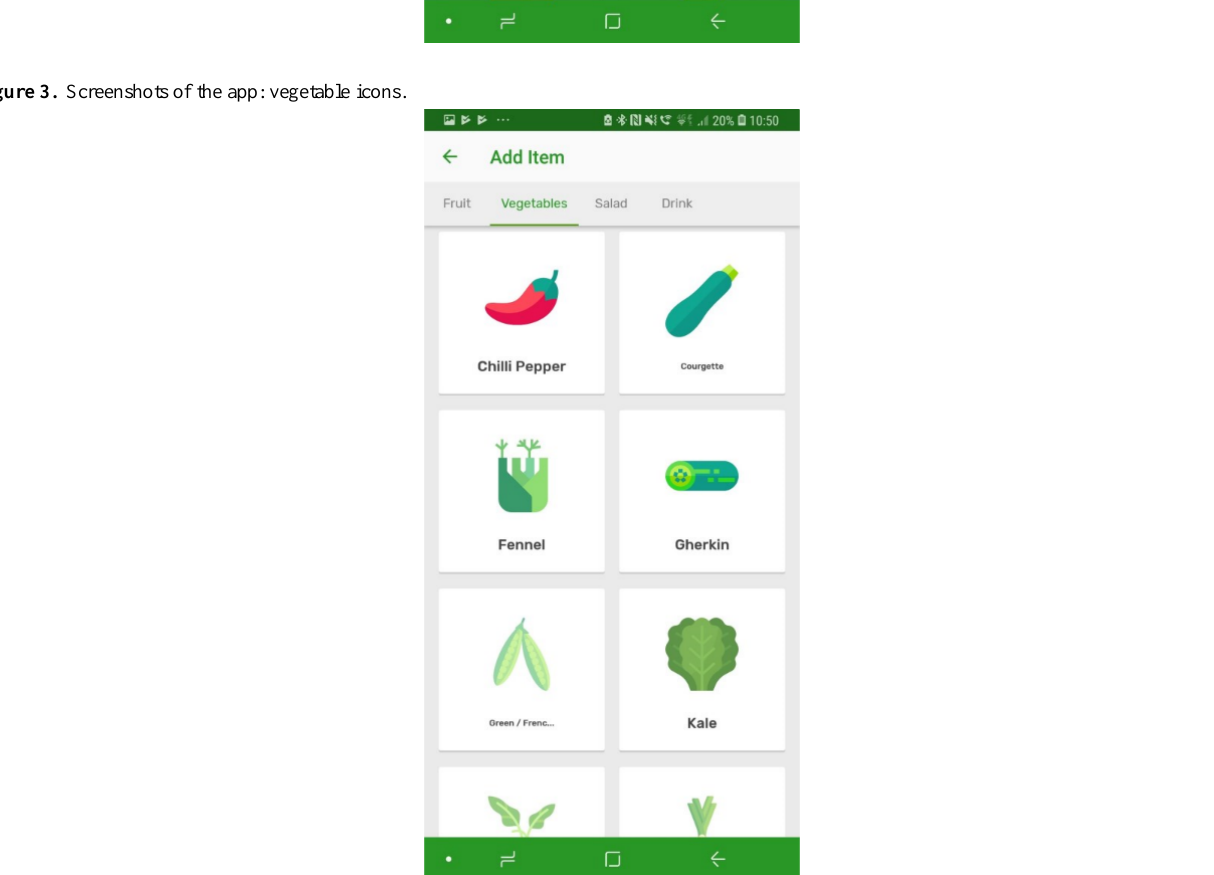
Figure 3. Screenshots of the app: vegetable